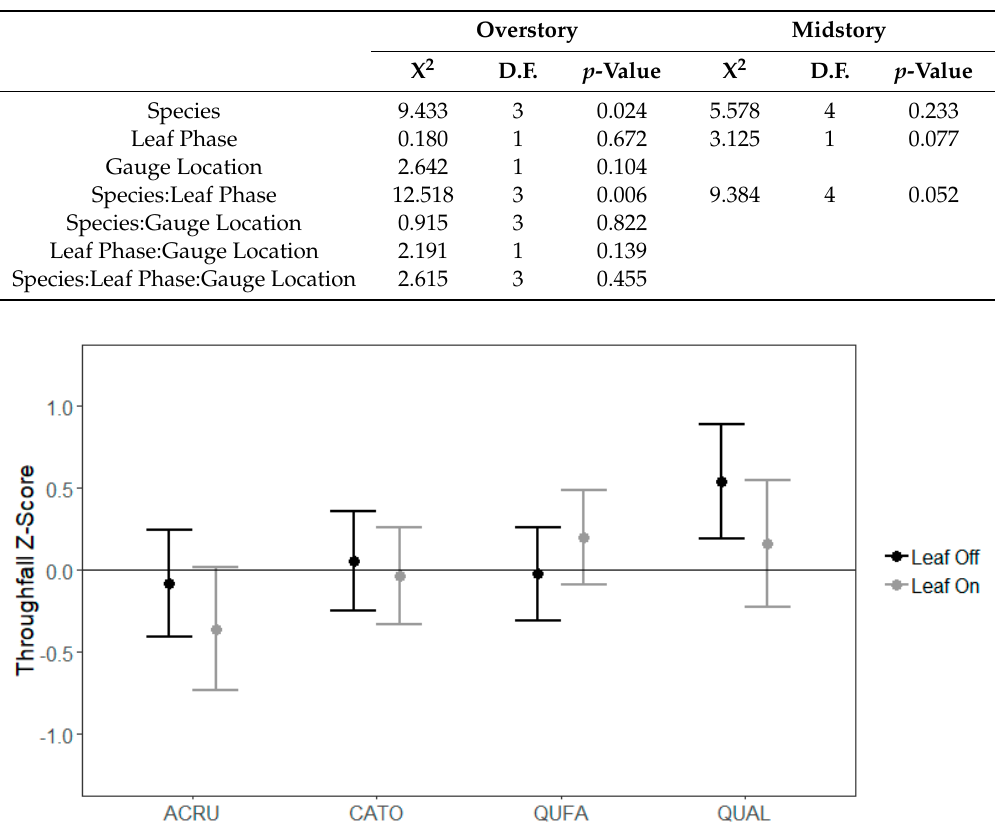
Figure 1. Mean throughfall z-scores (TF z ) with standard error bars for overstory species. Species codes: ACRU = red maple, CATO = mockernut hickory, QUFA = southern red oak, QUAL = white oak.